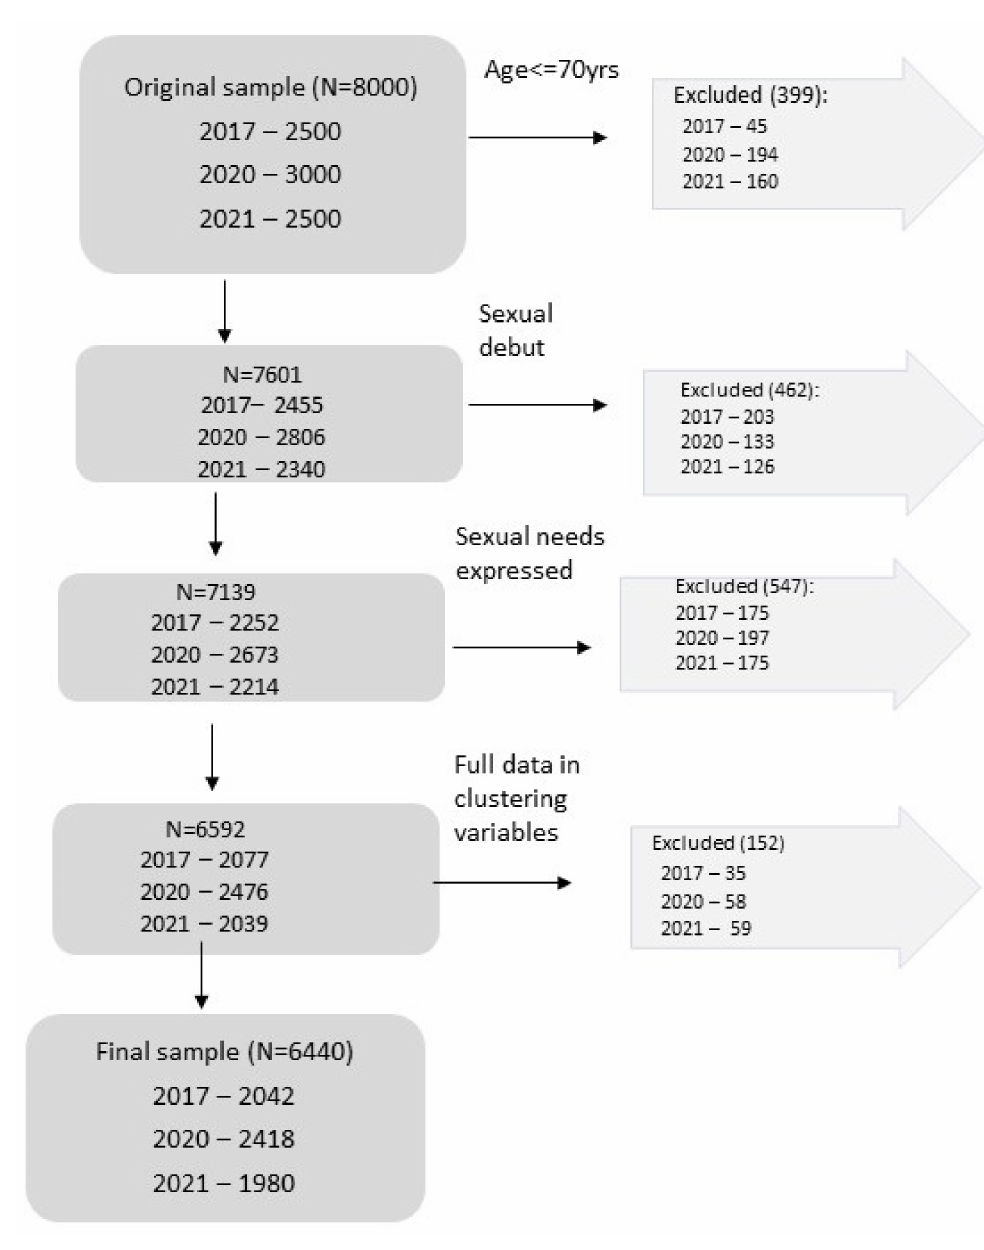
Figure A1. Flowchart of samples